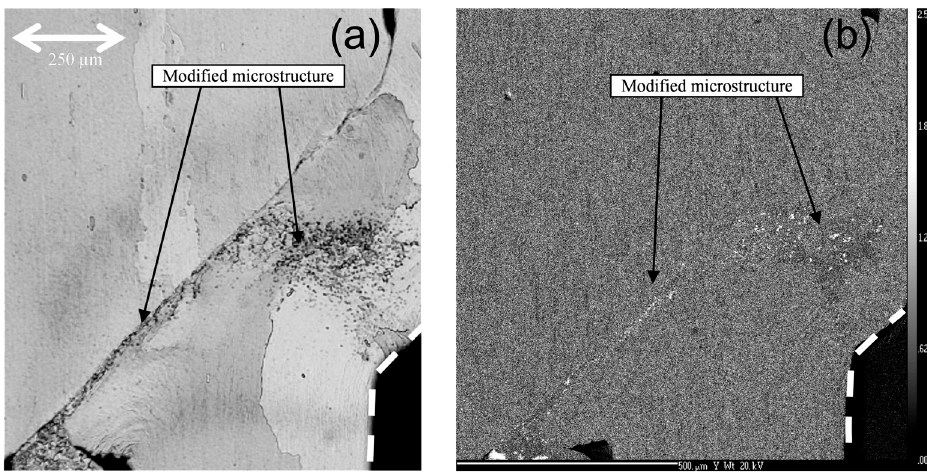
Figure 9. Evidence of modification of the metallurgical state of the sample welded using the parameters (F w ; I w ; t w ; C s ) = (2600 N; 18 kA; 10 ms; 0.8 mm). ( a ) Optical micrograph of an etched sample; ( b )